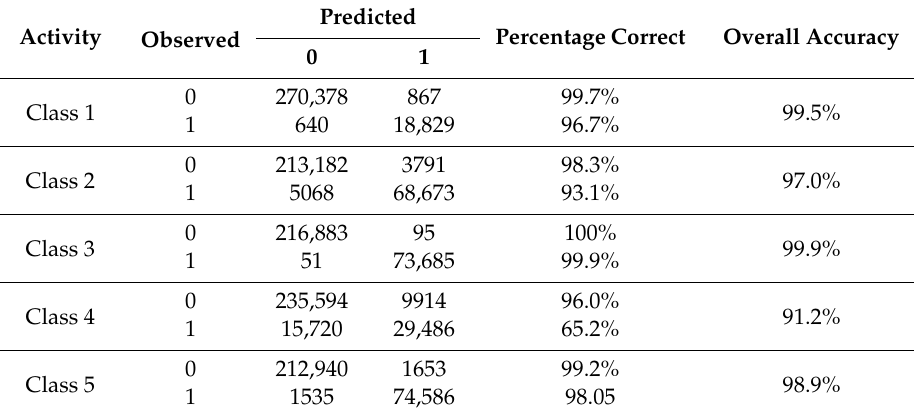
Table 5. Classification table using dataset B (26 July 2019